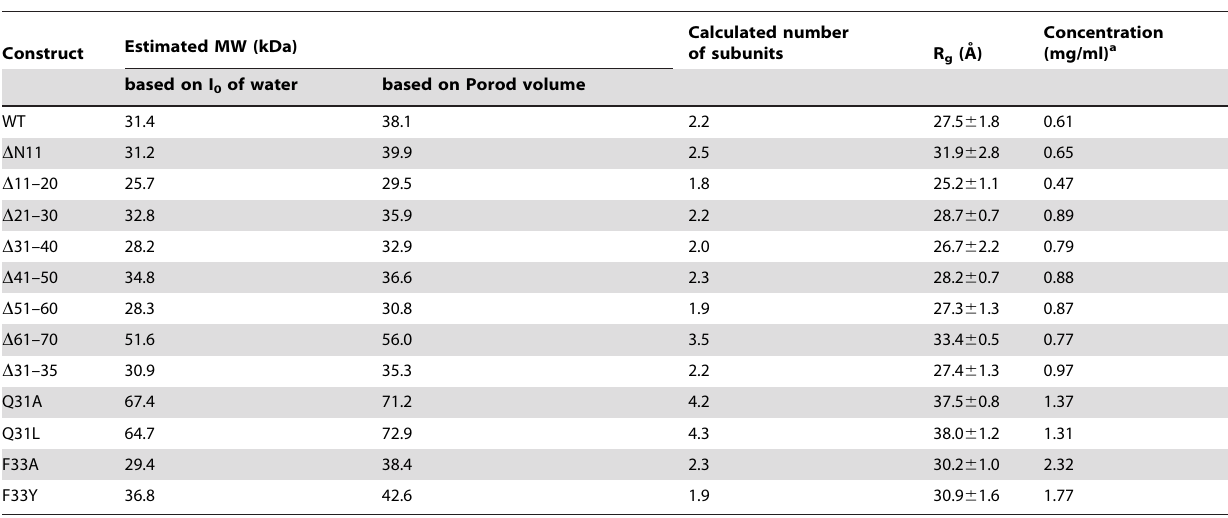
Table 2. SAXS data